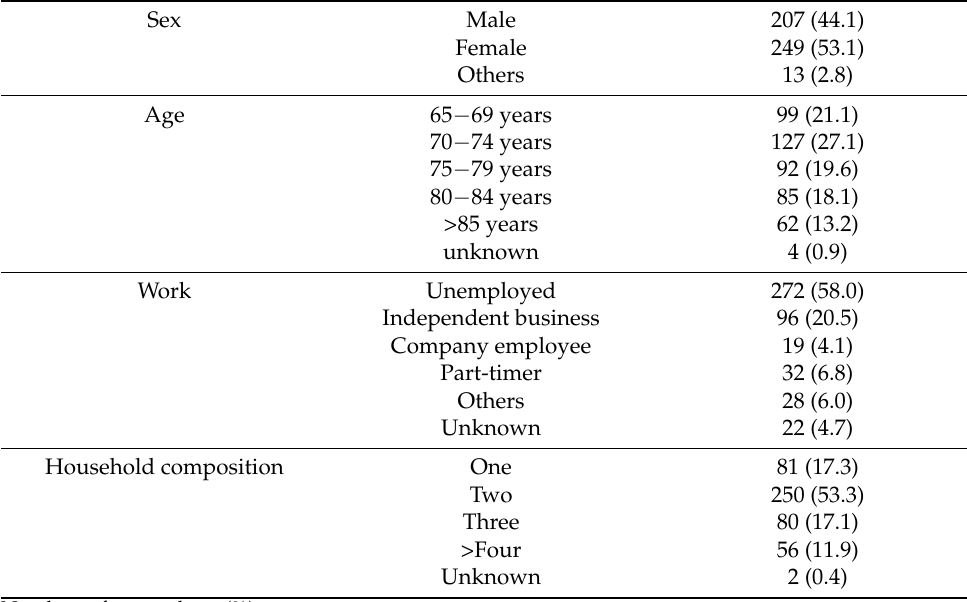
Table 2. Characteristics of the 469 respondents.